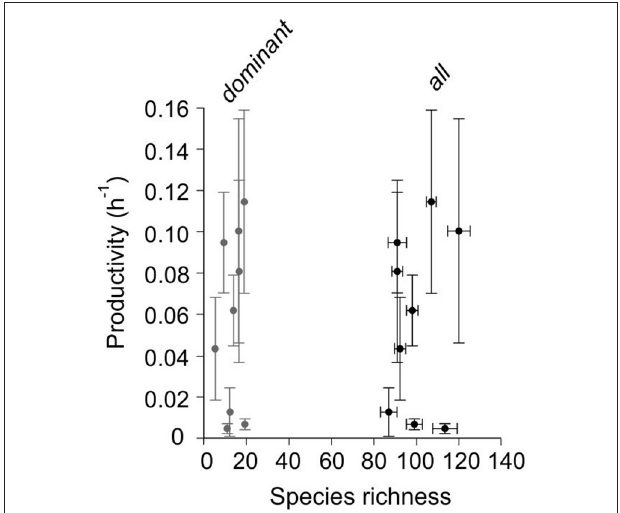
FIGURE 2 | Relationship between phytoplankton species richness and primary productivity. The number of dominant species ( > 80% community biomass) and the total number of species are plotted (gray and black dots, respectively). The error bars are the standard deviation. The volume of sampled examined under the microscope was increased three orders of magnitude with respect to traditional procedures.